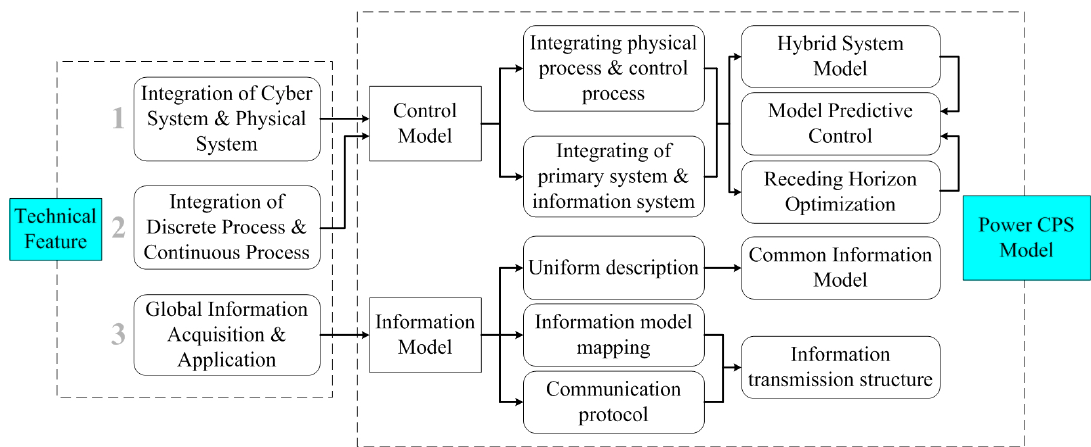
Figure 1. Relationship of technical features and model in Power Cyber Physical Systems (CPS).